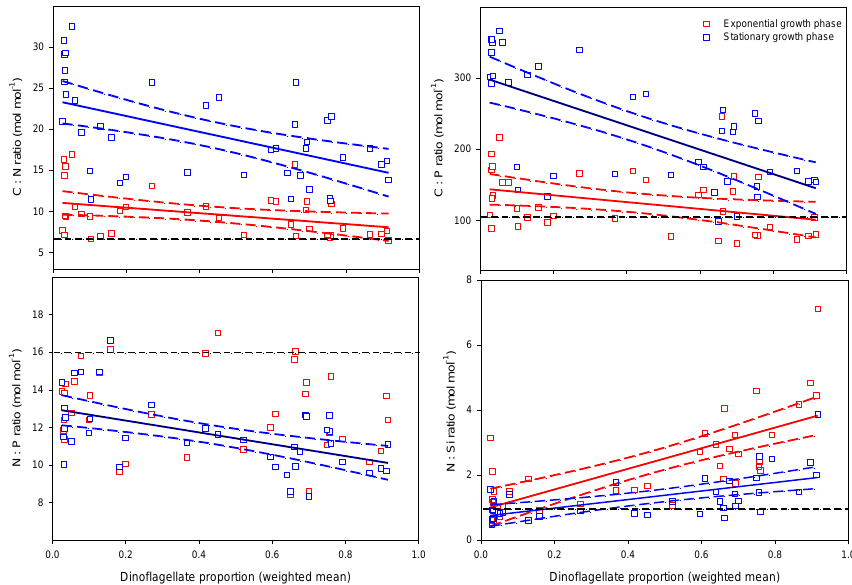
Figure 6. The particulate C:N, C:P, N:P, and N:Si ratios plotted against the weighted mean of dinoflagellate proportion during exponential (primary production peak) and stationary growth phase (end of experiment). The dashed horizontal line represent the Redfield–Brzezinski ratio (molar ratio); the red and blue line represents statistically significant linear regression of exponential and stationary growth phase data. Regression coefficients for the C:N ratio were slope = − 3.3, R 2 = 0.14, and p = 0.02 and slope = − 9.6, R 2 = 0.29, and p = 0.0004 for exponential and stationary growth phase, respectively. For the C:P ratio they were slope = − 48.0, R 2 = 0.13, and p = 0.03 and slope = − 171.4, R 2 = 0.45, and p <0.001 for exponential and stationary growth phase, respectively. For N:P ratio, the linear regression for expo- nential growth phase was not significant ( p = 0.23); the regression coefficients for stationary growth phase were slope= − 3.15, R 2 = 0.31, and p = 0.0002. For the N:Si ratio they were: slope = 3.06; R 2 = 0.51; p < 0.0001 and slope = 1.31; R 2 = 0.36 and p = 0.0001 for expo- nential and stationary growth phase